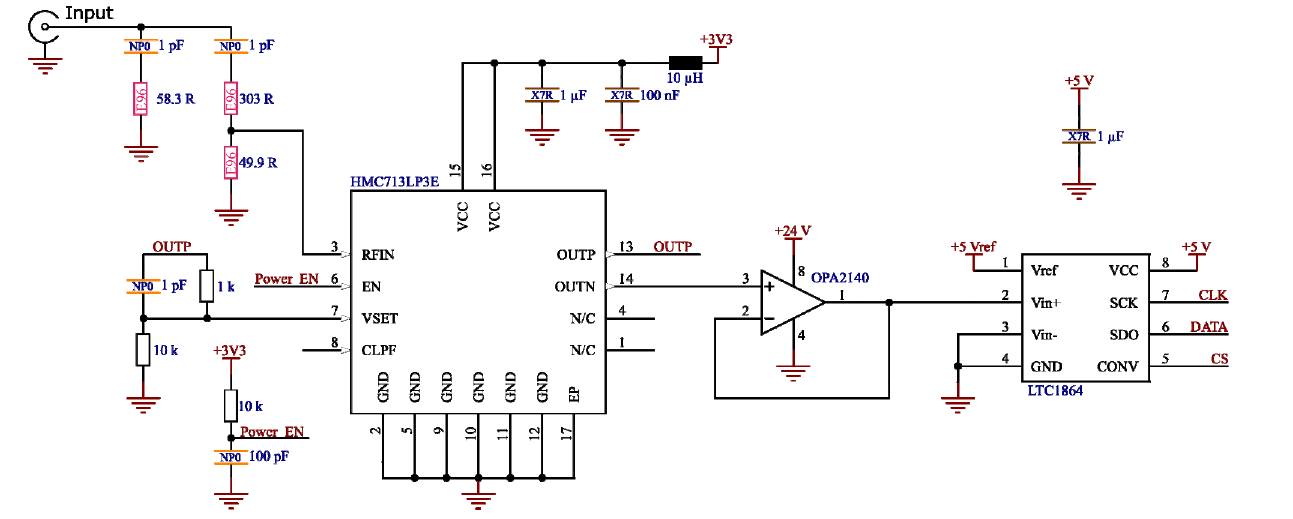
Figure 4. Circuit diagram of the input section including the power detector with the corresponding components and the ADC for analog ‐ to ‐ digital conversion.